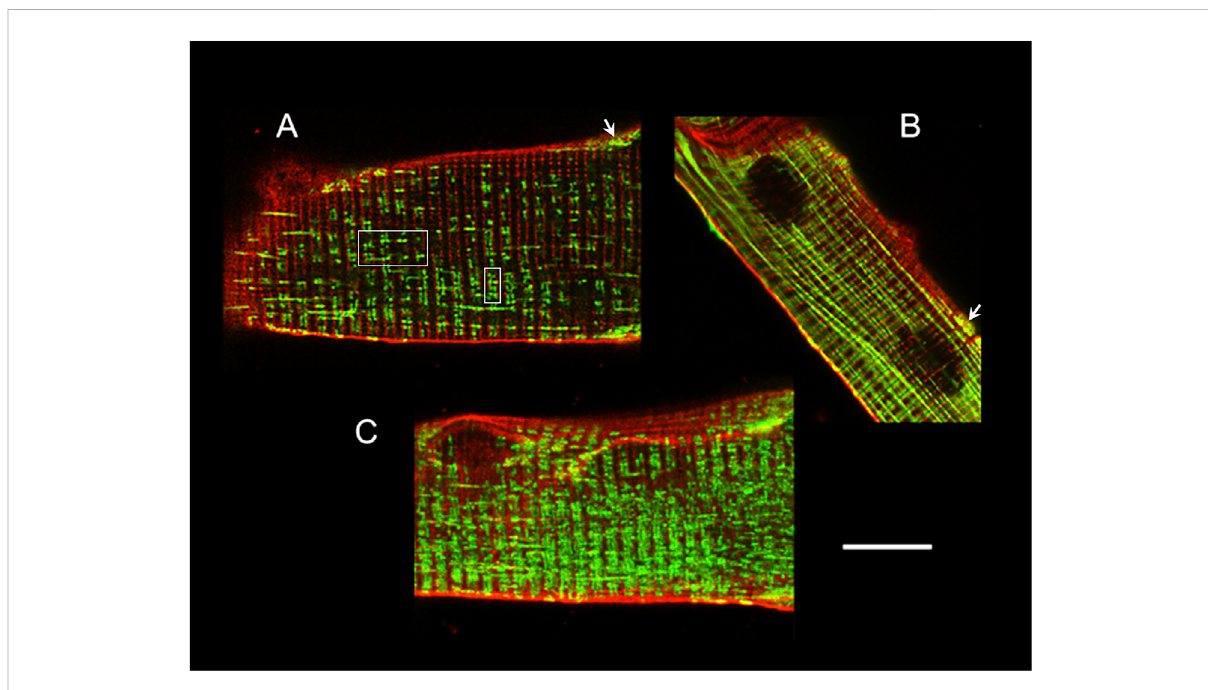
FIGURE 2 Mitochondria location and distribution in muscle fi bres. Confocal images of adult mouse FDB fi bres loaded with Di-8-Anneps (red) and Mitotracker Green (green) to stain membranes and mitochondria, respectively. The fi bre end in (A) shows the T-tubules and intermyo fi brillar mitochondria, either paired at both sides of the Z line near the center of the fi bre (white squares) or forming elongated structures, which are much more evident in (B) , and look like columns parallel to the long axis of the fi bre. The arrows in (A) and (B) point to typical clustered, less ordered, subsarcolemmal mitochondria. The mitochondrial network appearance is clearer under the 3D reconstruction shown in (C) . Calibration bar: 10 µm, applies to all